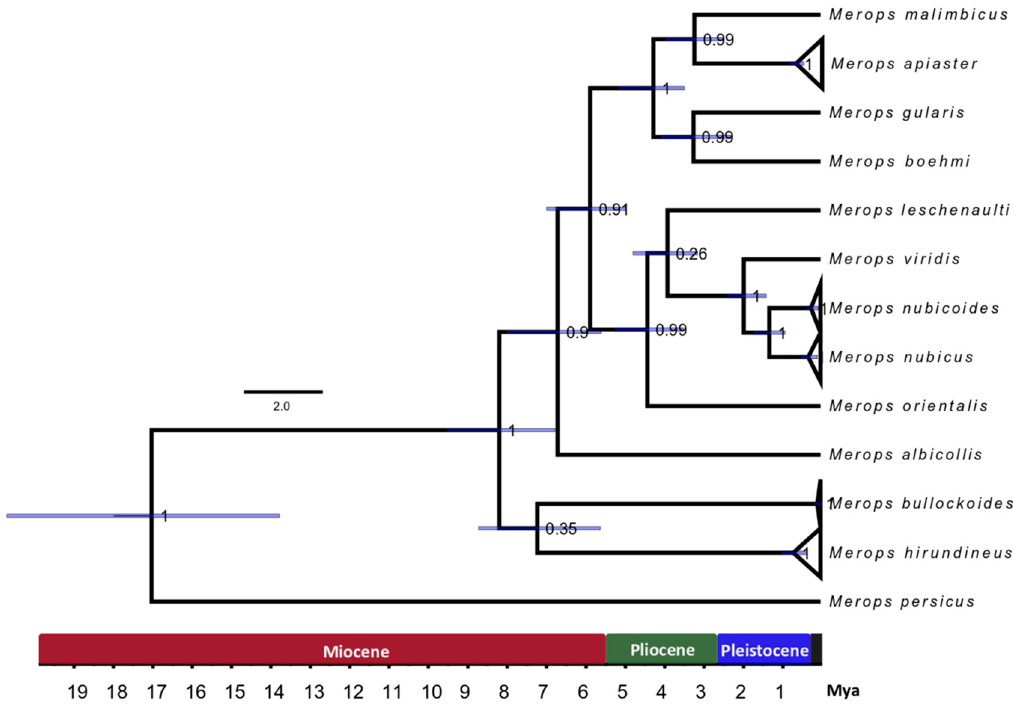
Figure 5. Phylogenetic relationships and molecular dating of Merops apiaster inferred throughout Bayesian analysis using Cyt b sequences (in total 1059 bp). Posterior probabilities are placed at the nodes.